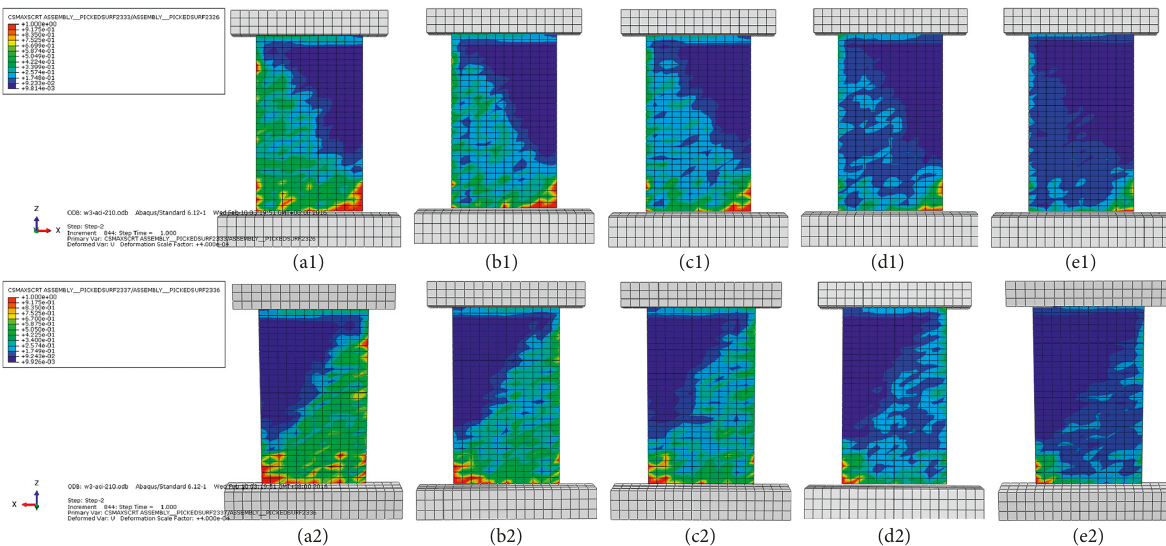
Figure 16: Maximum traction damage initiation criterion index CSMAXSCR of